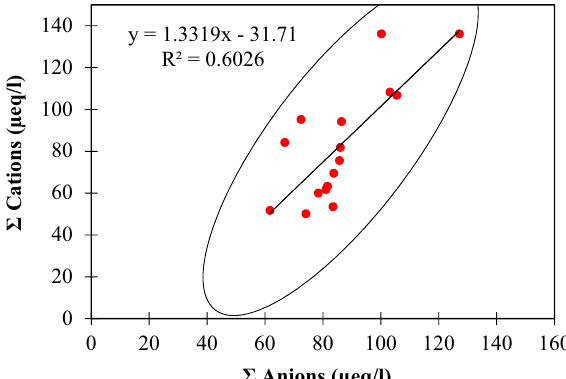
Figure 2. Correlation among the sum of anions and sum of cations during the ablation period of